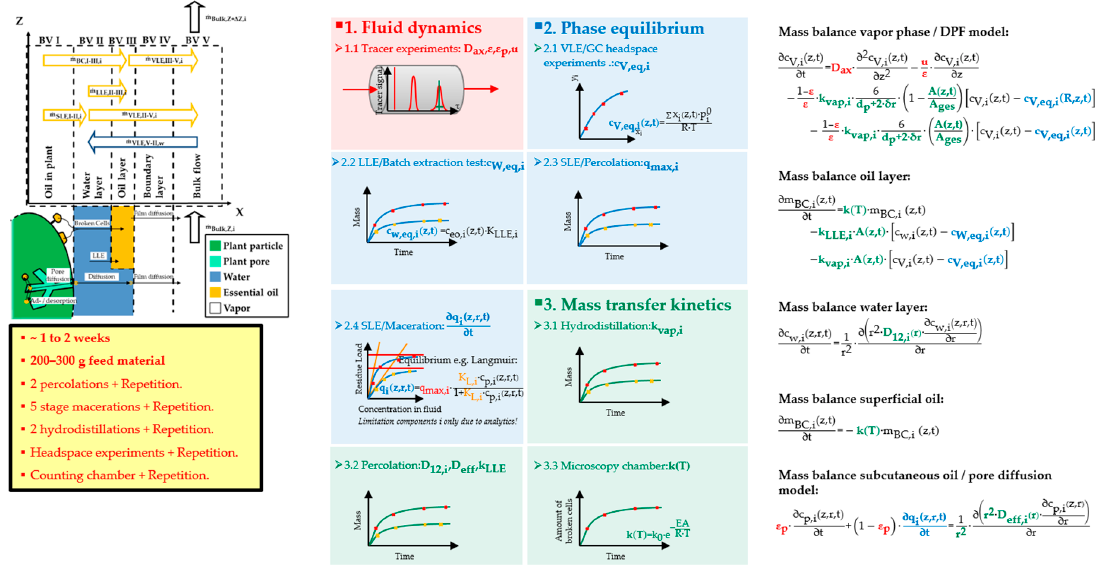
Figure 8. Steamdistillation—modelparameterdeterminationconceptoverview. SLE:Solid − Figure 8. Steam distillation—model parameter determination concept overview. SLE: Solid − Liquid Extraction;